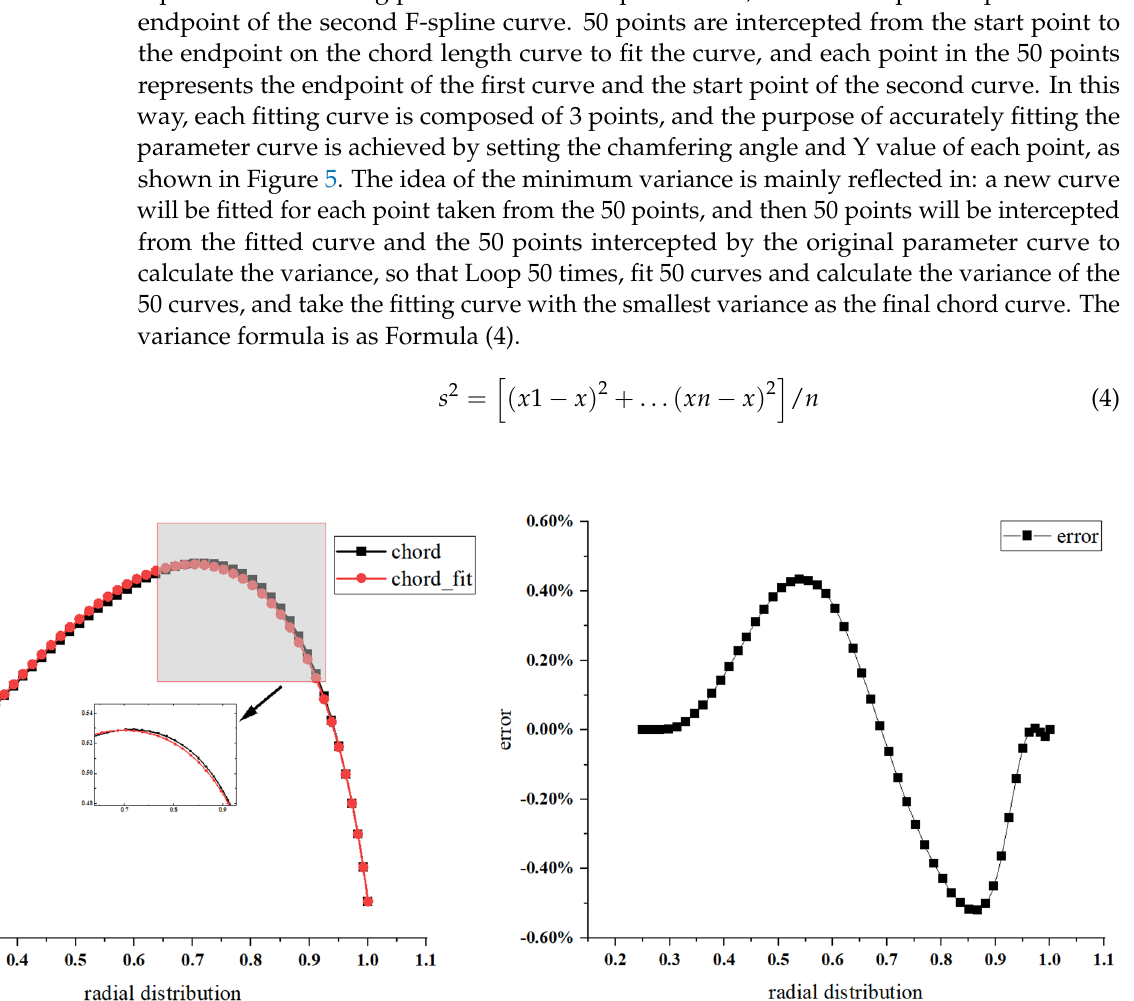
( b ) Figure 6. Comparison of pitch curve and pitch fitting curve: ( a ) curve comparison; ( b ) relative error.